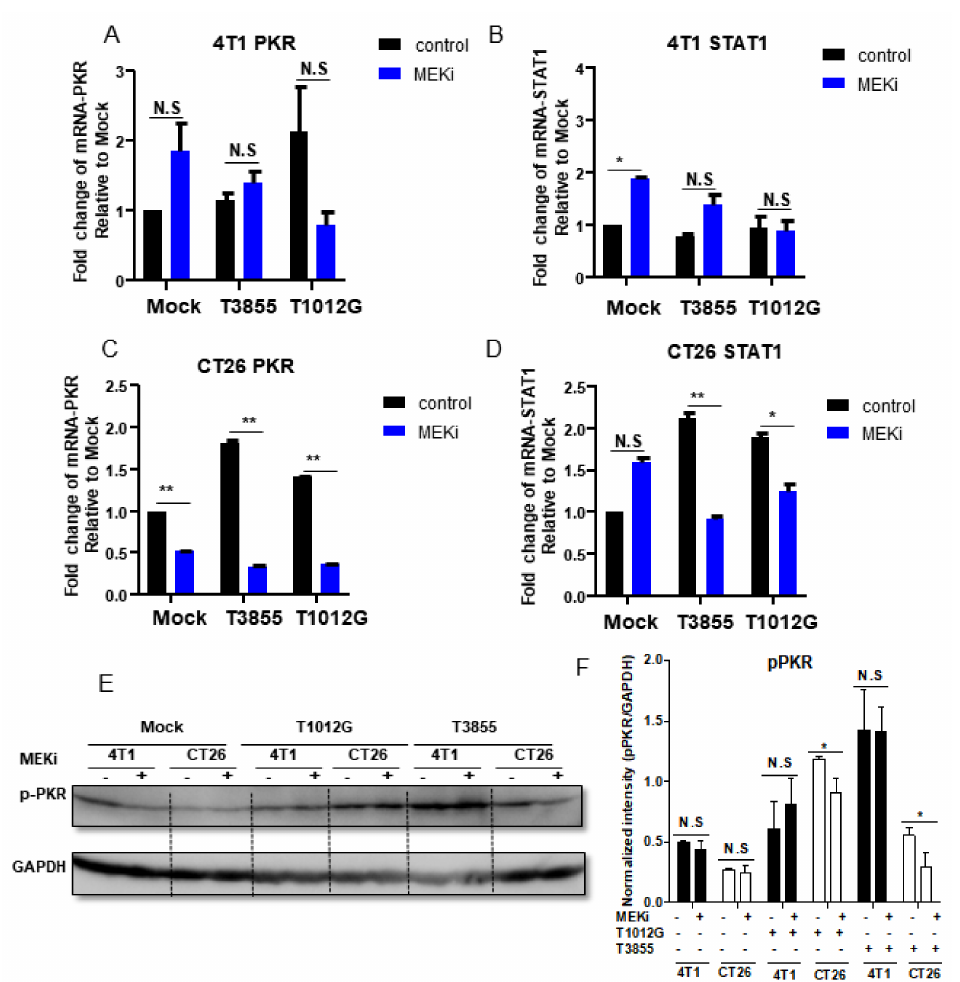
Figure 5. Decreased STAT1 and PKR expression in MEKi treated KRAS mutated cancer cells. 4T1 and CT26 cells were mock treated or pretreated with 0.25 µ M of Trametinib (MEKi) for 2 h and then mock infected or infected with 0.1 PFU/cell T1012G or T3855. The cell pellet was harvested at 24 h post-infection, respectively. The total RNAs were extracted and 0.5 µ g of RNAs were reverse transcribed to cDNA as described in Materials and Methods. The PKR and STAT1 mRNAs were quantified and normalized with respect to 18S rRNA and shown as fold change compared with mRNA from mock treated and infected cells (Panel ( A – D )). With the same treatment, cell pellets were harvested and the proteins were electrophoretically separated in a 10% denaturing gel and reacted with indicated antibodies (Panel ( E )). Quantification of the protein level of pERK in 4T1 and CT26 cells (Panel ( F )). N.S. (not significant); p > 0.05, * p < 0.05, ** p <